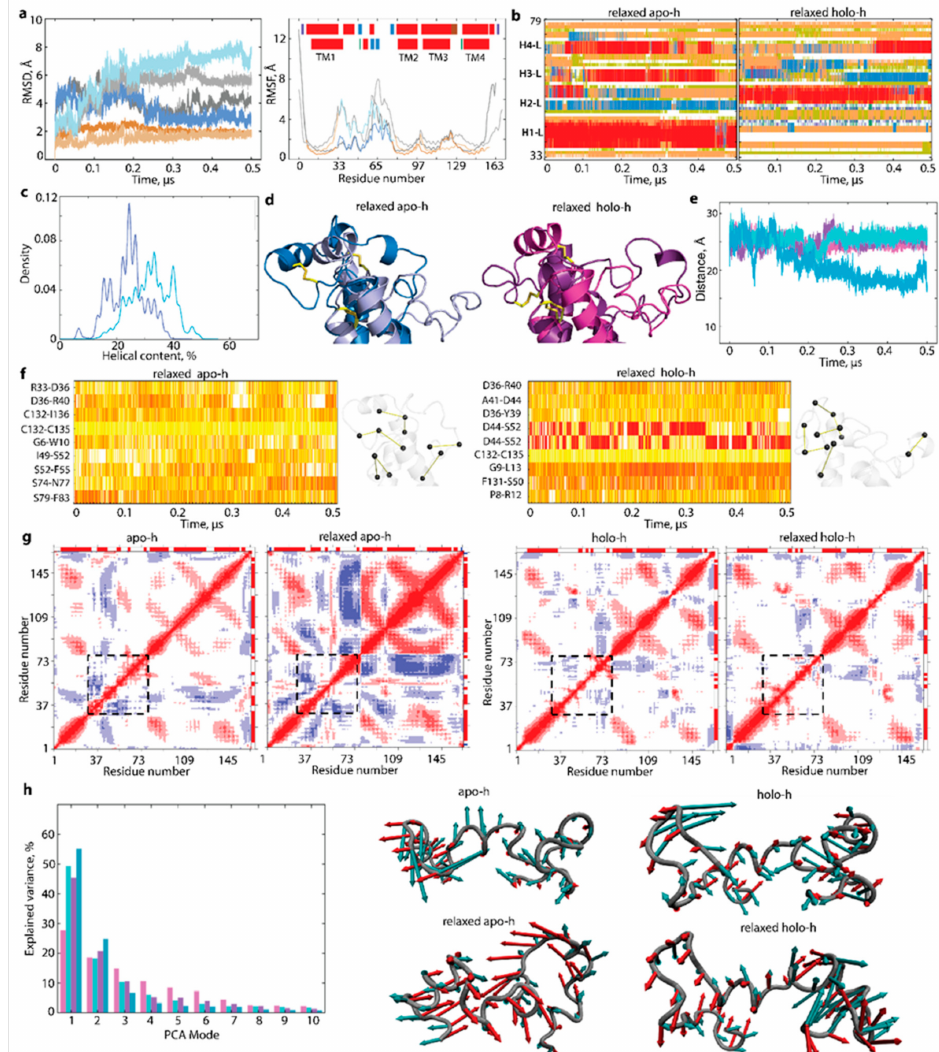
Figure 5. Conventional MD simulations of the homology models of hVKORC1 with conditioned H-bond Q78 ··· G62. ( a ) RMSDs from the initial coordinates computed for C α -atoms of the full-length protein (grey), TMD (brown), and L-loop (blue) after fitting to the initial conformation (t = 0 ns) of each related domain (left). RMSFs computed for the C α atoms of each form after fitting on the initial conformation (right). (Insert) Secondary structures interpretation of each form’s average structure, relaxed apo-h (top), and relaxed holo-h (bottom). α - and 3 10 -helices are shown in red and blue, respectively. Conformations are distinguished by colour: relaxed holo-h and relaxed apo-h are in